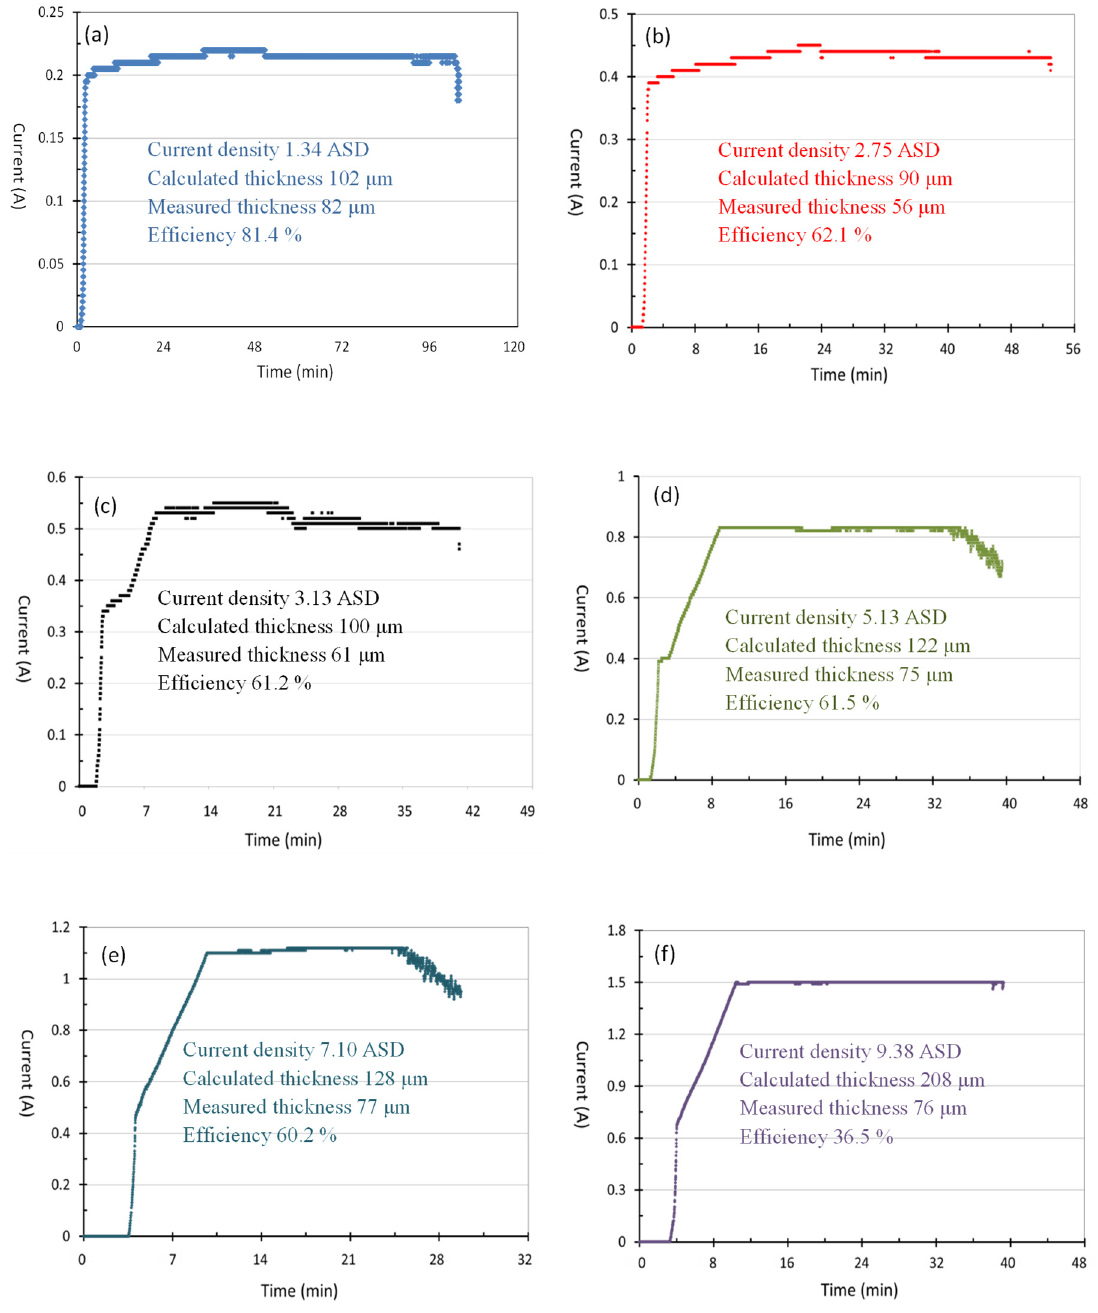
Figure 9. I-T curves of hard anodization with current densities of ( a ) 1.34, ( b ) 2.75, ( c ) 3.13, ( d ) 5.13, ( e ) 7.10, and ( f ) 9.38 ASD.